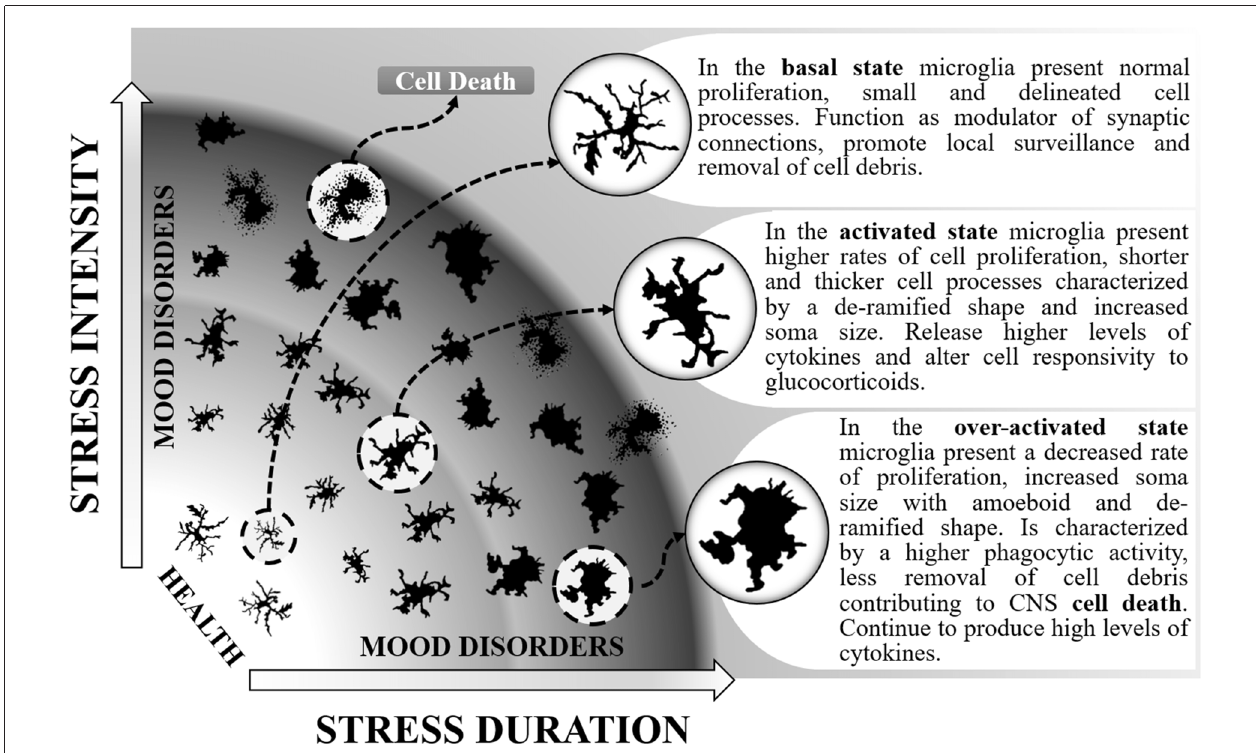
FIGURE 1 | Different stages of microglial activation caused by changes in the intensity and duration of social stressors that can maintain individuals in a healthy state or contribute to both anxiety and depressive-like behaviors. In the basal state, microglia can be distinguished by normal levels of immunoreactivity to ionized calcium-binding adapter molecule 1 (Iba-1) and CD11b. In this state, enable proper coping to stress situations. When activated, microglia proliferate, release higher levels of interleukin-1 β (IL-1 β ), interleukin-6 (IL-6) and tumor necrosis factor- α (TNF- α ), present higher expression of toll-like receptor 4 (TLR-4), chemokine (C-C motif) ligand 2 (CCL 2 ), CX 3 CR 1 ) and decreased levels of glucocorticoid-induced leucine zipper (GILZ) and FK506 binding protein 51 (FKBP51). They can be distinguished by higher immunoreactivity to Iba-1, CD11b, CD14 and CD68. During the activated state, the release of pro-inflammatory mediators and the altered response to glucocorticoids may lead to anxiety. The activated state can also be protective by resuming stress effects. As a consequence, microglia return to their basal state. Otherwise, persistent stress shifts microglia to an over-activated state. Overactive microglia continue to release pro-inflammatory mediators (IL-1 β and IL-6). They can be distinguished by higher immunoreactivity to CD68 hi and possibly lower levels of CX 3 CR 1 and iNOS antibodies. Along with the microglial phagocytic activity occurs a higher rate of cell death, including microglia as well as neuronal and other glial cells. This effect reduces their capacity to remove cell debris and surveillance of the inter-neuronal space, altogether leading to